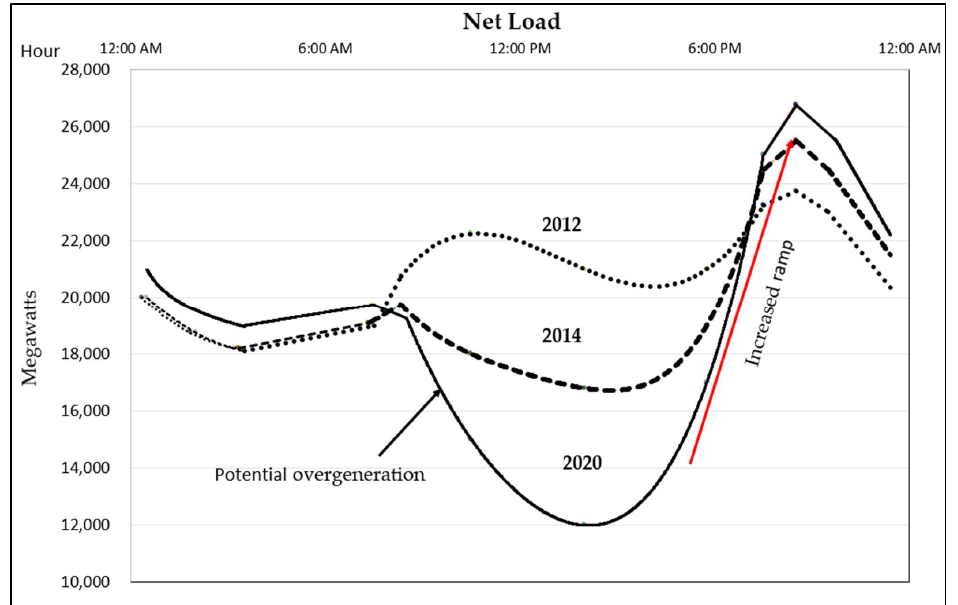
Figure 2 . Adapted from the California CAISO ‘Duck Curve’ illustrating the impact of intermittent renewable power generation. Adapted from Ref. [31].